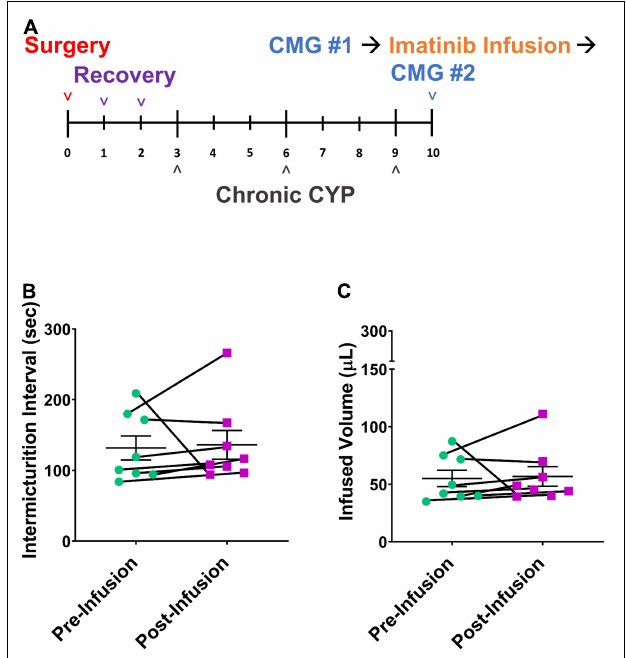
FIGURE 6 | Imatinib mesylate treatment via intravesical infusion does not significantly affect bladder function in mice with chronic (8 day) CYP-induced cystitis. (A) Chronic CYP-induced cystitis (75 mg/kg, every 72 h for 8 days) experimental schedule for imatinib mesylate treatment via intravesical bladder infusion (50 µ M, 30 min, 0.5 mL). (B,C) Imatinib treatment via intravesical bladder infusion did not significantly affect IMI or IV in chronic CYP-induced cystitis, female mice. n = 7–9. Values are mean ± SEM by Student’s paired t -test. CMG, cystometrogram.